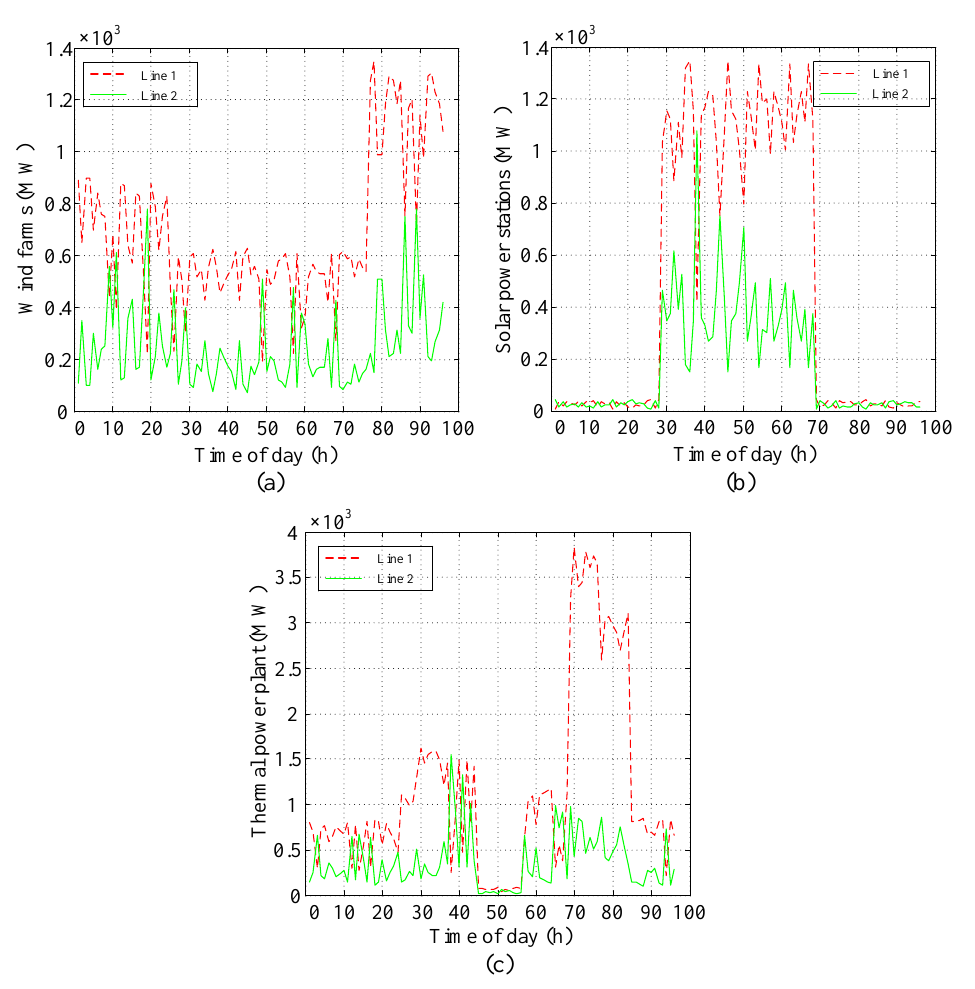
Figure 4. Electricity transported through each transmission line: ( a ) Wind farms, ( b ) Solar power stations and ( c ) Thermal power